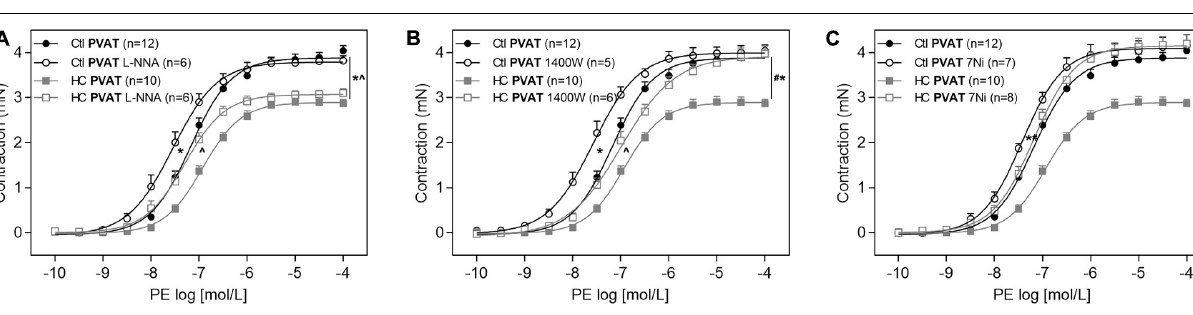
FIGURE 8 | Implication of eNOS, iNOS, and nNOS in the effect of HC diet on control of vascular tone induced by PVAT. Cumulative concentration-response curves for PE in the presence of PVAT in aortas of control and HC groups previously incubated or not with (A) L-NNA, (B) 1,400 W, or (C) 7Ni. Values represent mean ± SEM. The total number of animals required to carry out the experiments in each group ( n ) is presented in parentheses in the graphs. Statistical significance was determined using two-way ANOVA followed by Holm–Sidak’s post hoc test. * p < 0.05 vs. control PVAT; # p < 0.05 vs. HC PVAT; ∧ p < 0.05 vs. control PVAT L-NNA or 1,400 W represent the differences in the Emax and pD 2